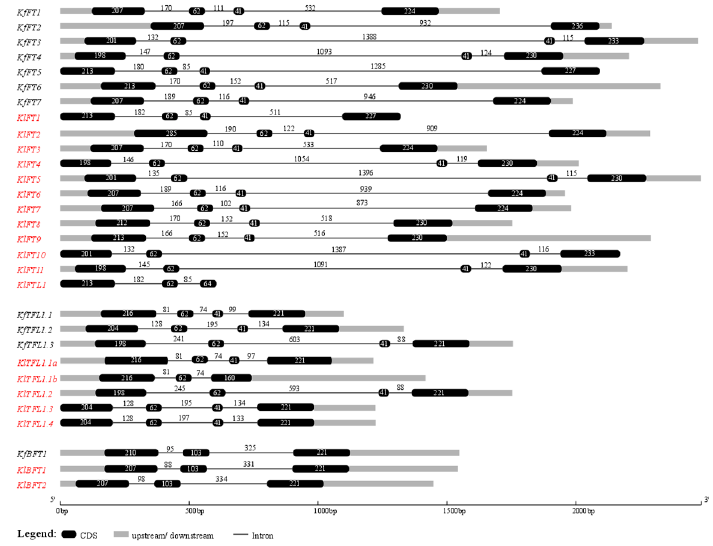
Figure 4. Structural organization of the PEBP family genes in Kalanchoë. The white boxes represent 5 ′ and 3 ′ untranslated regions (UTRs) and black boxes represent coding regions. The introns in coding region are presented as black lines. The scale bar at the base represents the length of the genes in bp. Information was retrieved from Phytozome: Kalanchoe fedtschenkoi v1.1, Kalanchoe laxiflora v1.1, DOE-JGI .